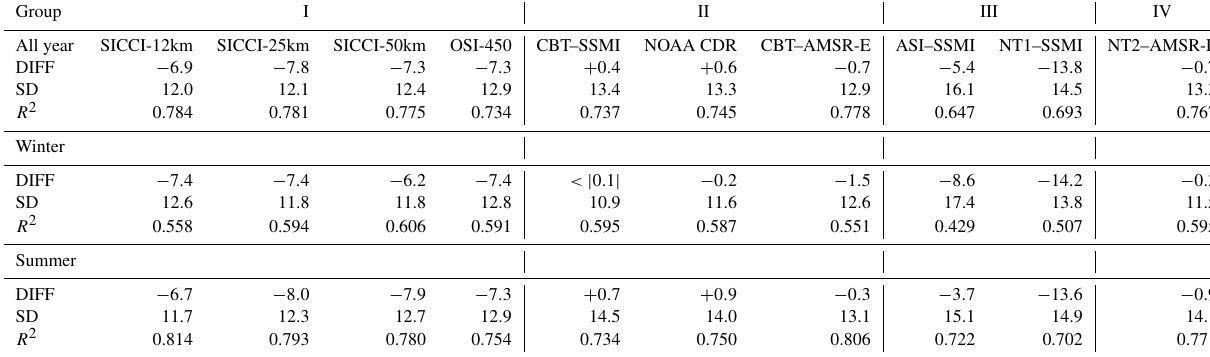
Table 5. Summary of the statistics of the comparison between daily mean ship-based and satellite SIC data (see Fig. 15, black symbols) for – from top to bottom – the entire year, only winter and only summer. DIFF is the mean difference satellite minus ship-based SIC, and SD is the respective standard deviation; R 2 is the squared linear correlation coefficient. All concentration values are given in percent. Group I II III All